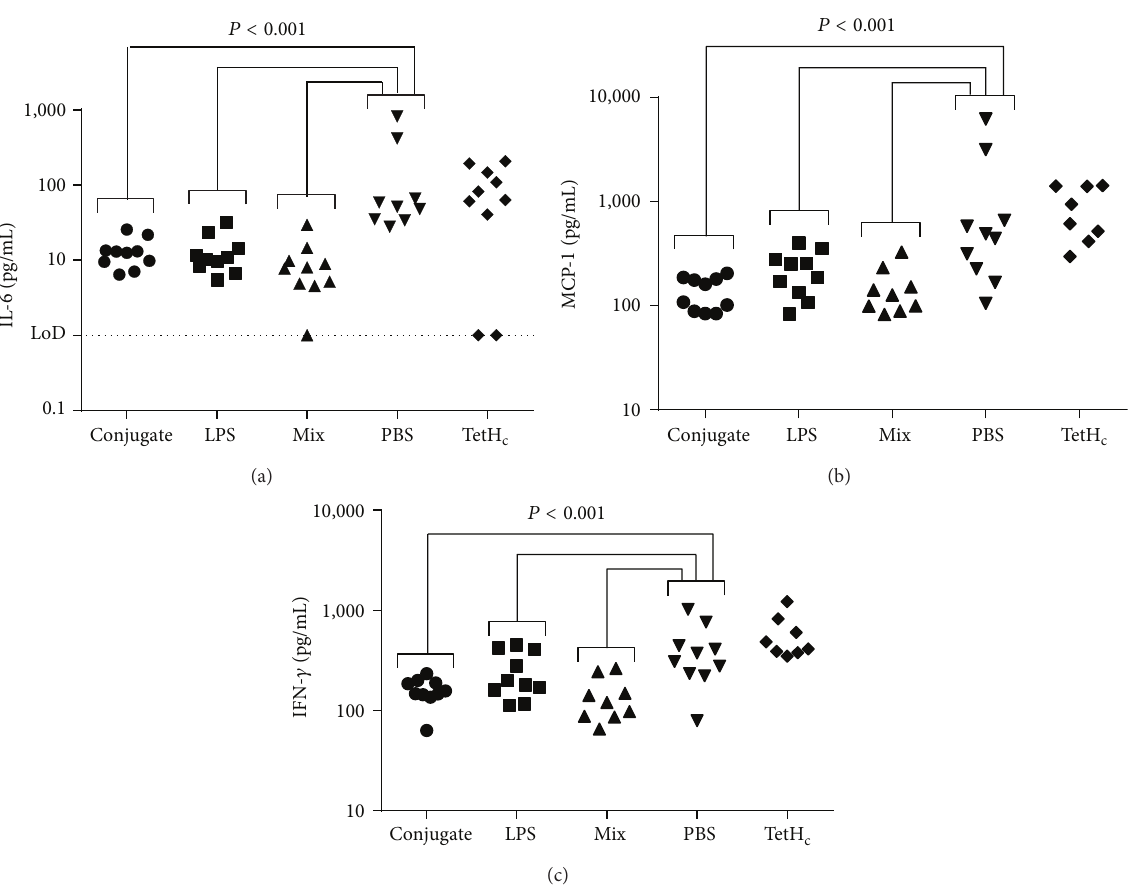
Figure 5: Cytokine production in spleens 48 hours after infection. Mice were vaccinated three times at two-week intervals with 10 𝜇 g of either the TetH c -LPS conjugate ( ∙ ), LPS alone ( ◼ ), a mix of unconjugated LPS and TetH c ( 󳵳 ), TetH c only ( ⧫ ), or PBS ( 󳶃 ) and challenged five weeks after the final vaccination with approximately 40 MLD of B. pseudomallei K96243. Forty-eight hours after challenge, mice were culled and the spleens were removed and assayed for cytokine production. Data is shown for replicate studies and shows the calculated concentration of IL-6 (a), MCP-1 (b), and IFN- 𝛾 (c) and was analysed by univariate linear model. Significant differences are shown. Where no markers are present, P was greater than